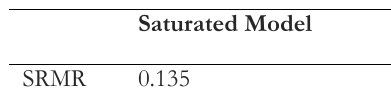
Table 8. SRMR criterion (source: software